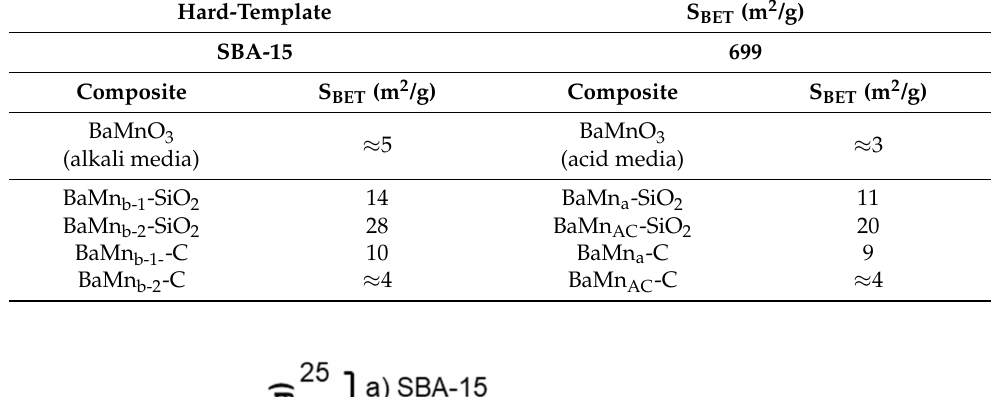
Table A2. Specific surface area (S BET ) of composite materials before and after silica removal and calcination.